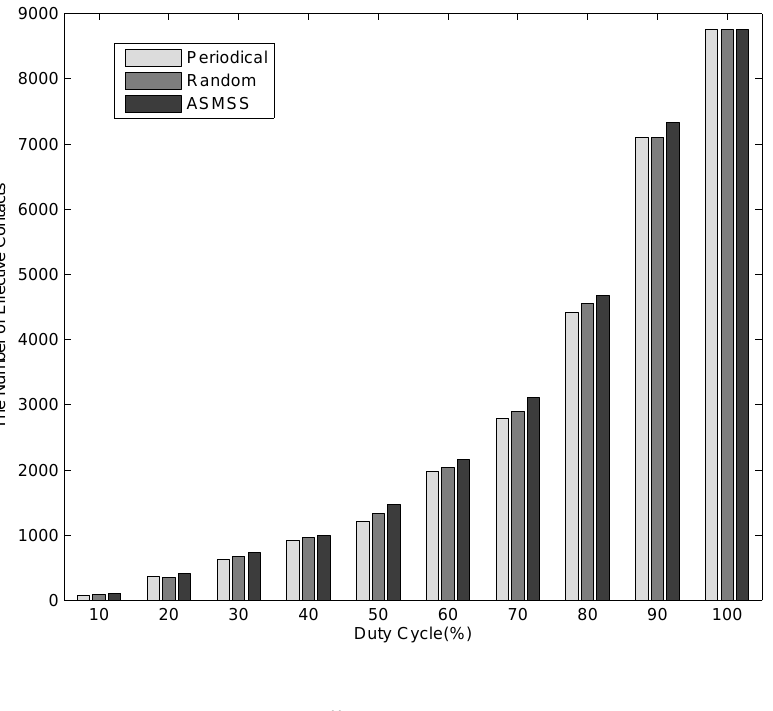
Figure 6. Effective Contacts ASMSS